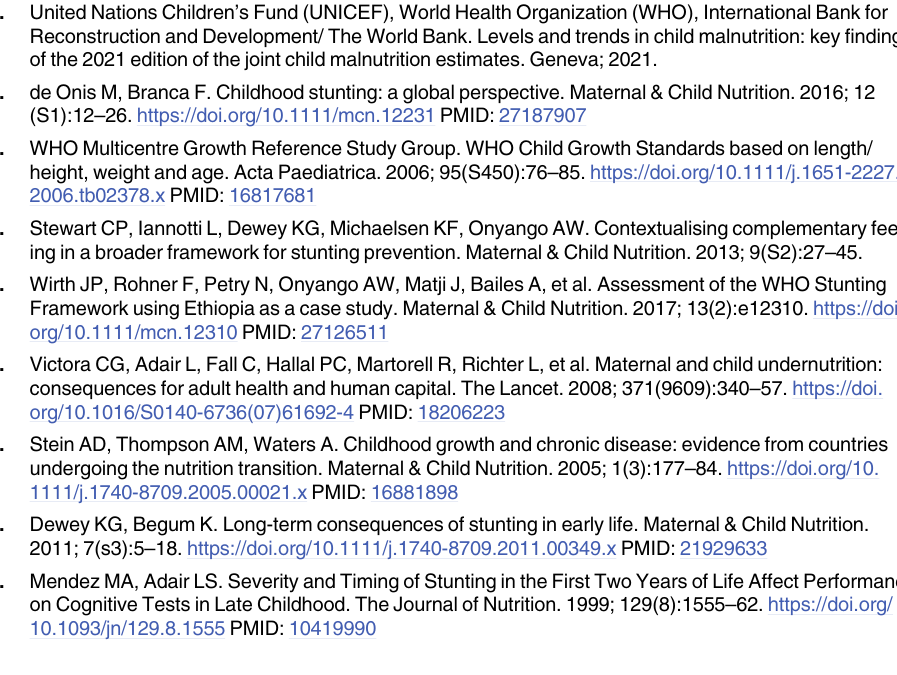
S1 Fig. Sample selection in the Angola 2015–2016 Demographic and Health Survey (DHS). Flowchart describing number of clusters (primary sampling units), households, women, and children selected for participation, number excluded with reason for exclusion, and number of participants included in study sample. S2 Fig. Prevalence of stunting according to child age. Graph shows the prevalence of stunt- ing expressed as proportion with 95% confidence interval (95% CI), according to child age- group categorized in 6-month